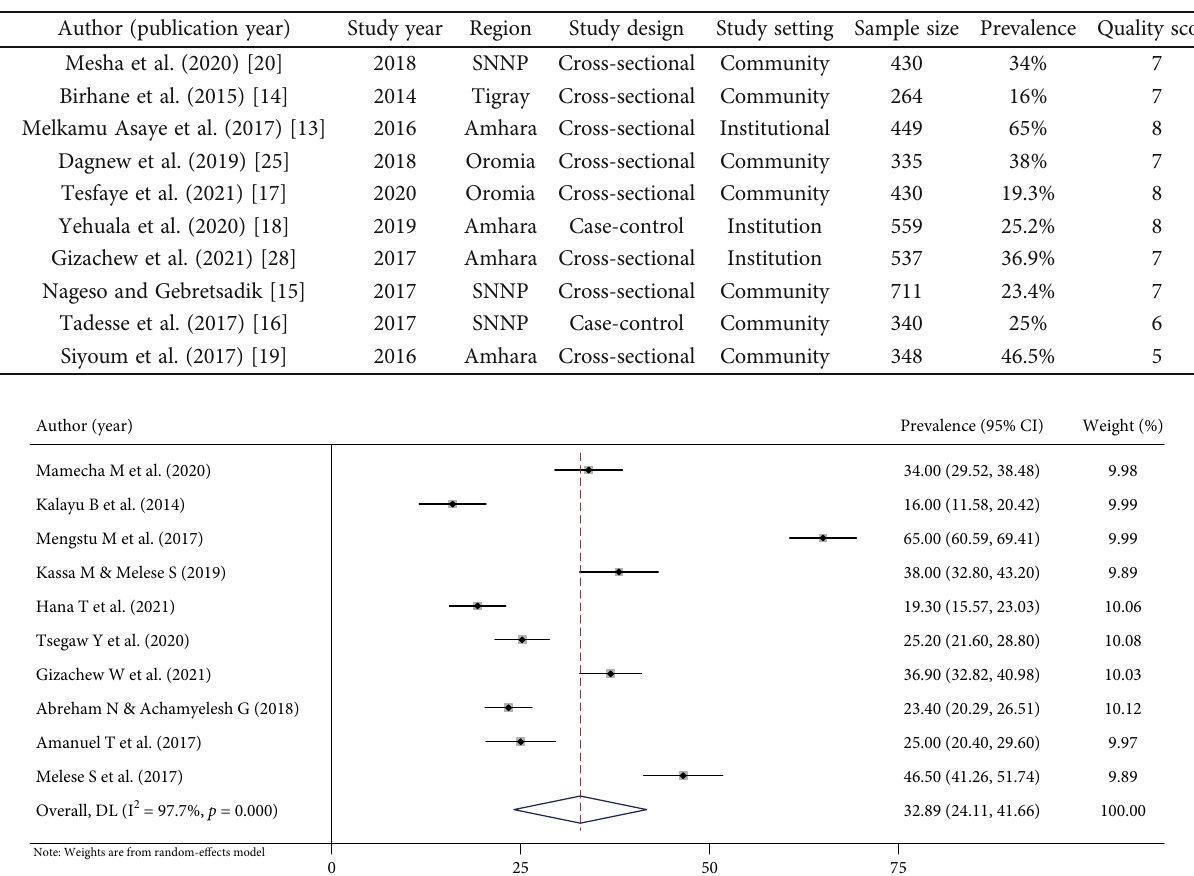
Table 1: Characteristics of the selected studies for systematic review and meta-analysis of the factors associated with Implanon discontinuation in Ethiopia, 2022.